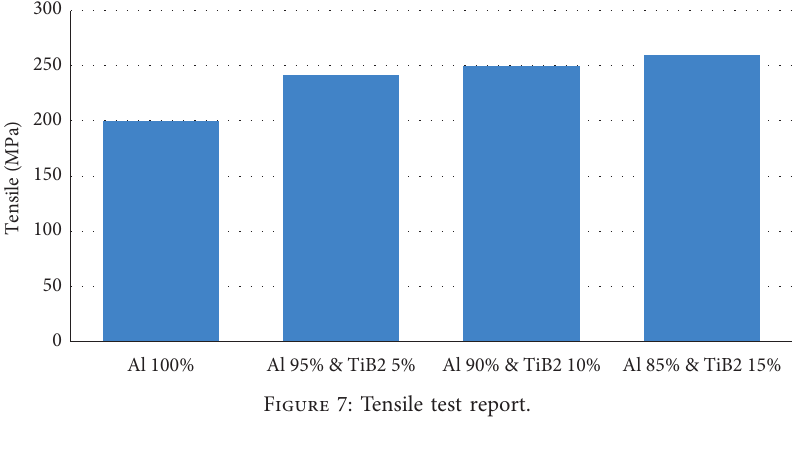
Figure 7: Tensile test report.